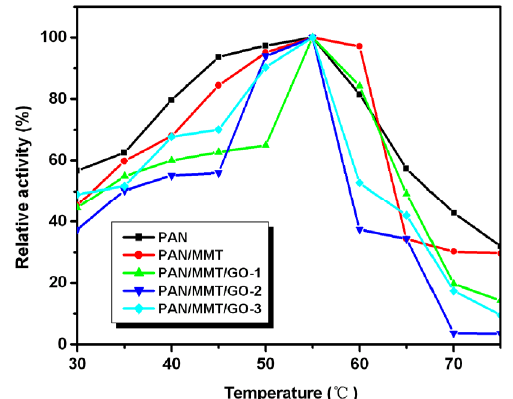
Figure 6. Optimum temperature of immobilized laccase on different